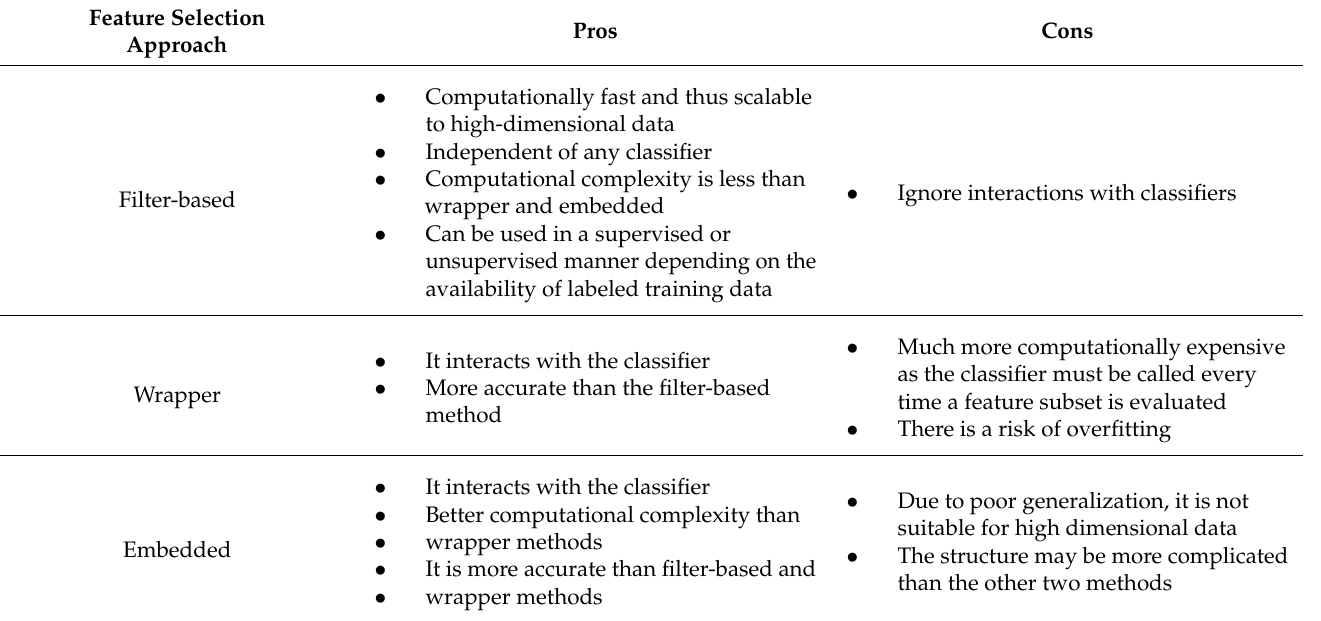
Table 1. Strengths and weaknesses of FS